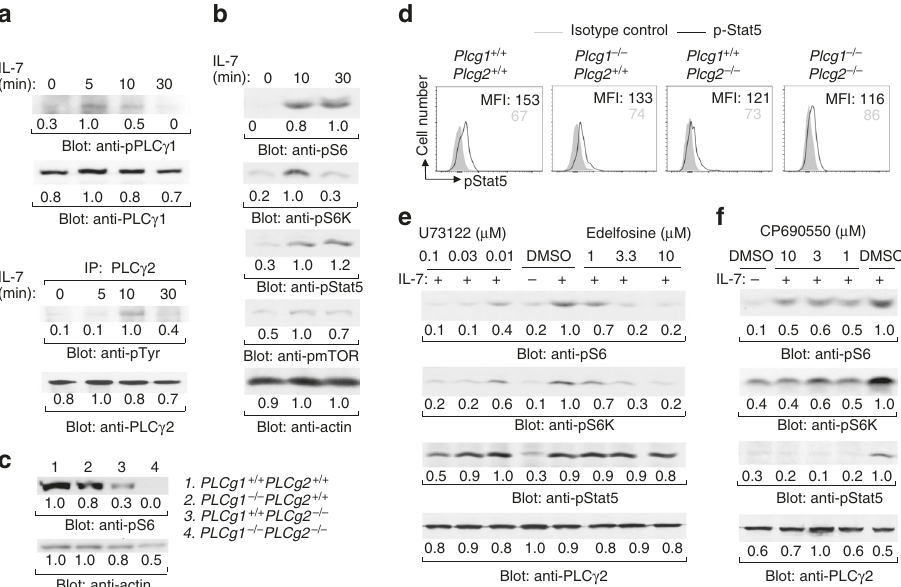
Fig. 6 Inhibition of the PLC γ pathway impairs IL-7-induced mTOR activation. a PLC γ 1 and PLC γ 2 are phosphorylated upon IL-7 stimulation. Pro-B cells derived from Rag1 -de fi cient mice were stimulated with IL-7. Cell lysates were subjected to western blot analysis (upper). Cell lysates were immunoprecipitated (IP) with anti-PLC γ 2 antibodies and precipitated proteins were immunoblotted with the indicated antibodies (lower). b IL-7 stimulation activates the mTOR pathway. Pro-B cells derived from Rag1-de fi cient mice were stimulated with IL-7 and cell lysates were subjected to western blot analysis. c PLC γ 1/PLC γ 2 double de fi ciency impairs mTOR activation. YFP + CD45.2 + pre-pro-B cells (fraction A) were sorted from the indicated BM transplantation recipients and cell lysates were subjected to western blot analysis. d PLC γ 1/PLC γ 2 double de fi ciency does not affect Stat5 activation. BM cells from the indicated recipients were stained with anti-B220 and anti-CD43 antibodies, followed by intracellular staining with anti-phosphor-Stat5 (pStat5) antibodies or isotype controls. Numbers indicate the mean fl uorescent intensity (MFI) of B220 + CD43 + cells of pStat5 (black) or isotype controls (gray) staining. e , f Inhibition of the PLC γ pathway or Jak3 impairs IL-7-induced activation of mTOR. Pro-B cells derived from Rag1 -de fi cient BM were pre- treated with DMSO, U73122, edelfosine, or CP-690550; and then stimulated with IL-7. Cell lysates were subjected to western blot analysis. The number beneath each band in the western blot indicates the relative intensity of the corresponding band. Data shown are representative of 3 ( a , b , d ), 4 ( c ), 5 ( e